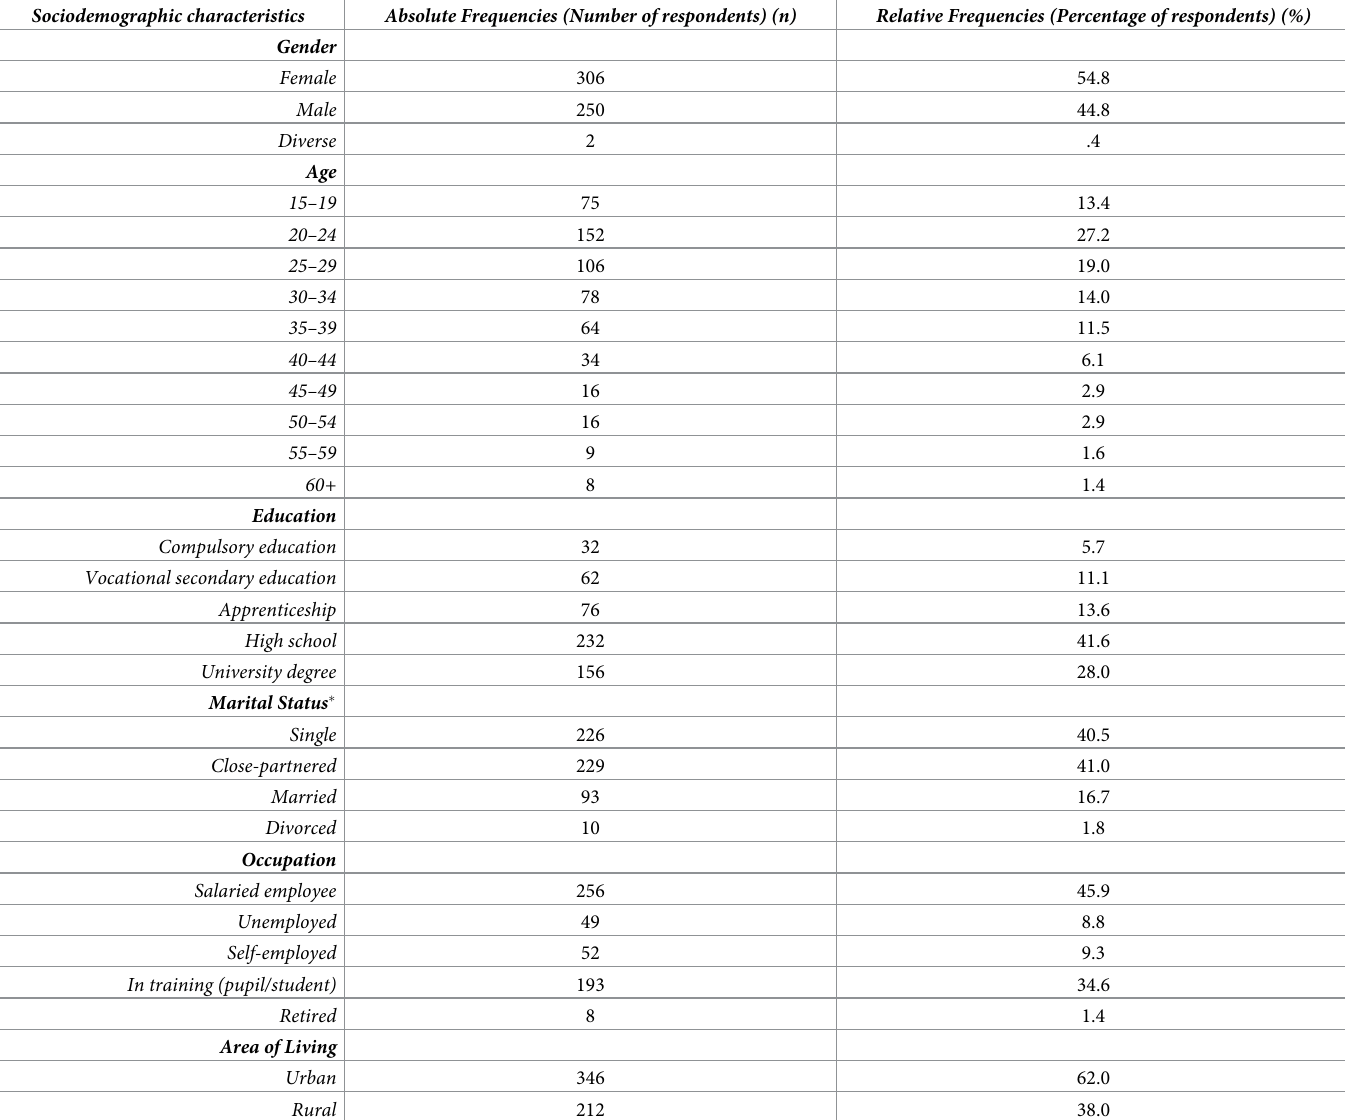
Table 1. Sample description with regard to sociodemographic variables (n = 558). Sociodemographic